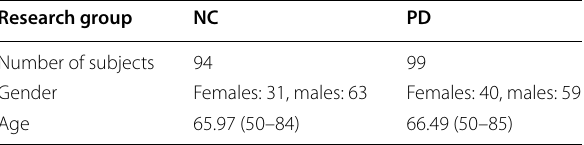
Table 2 Demographics of subjects with SPECT scans presented